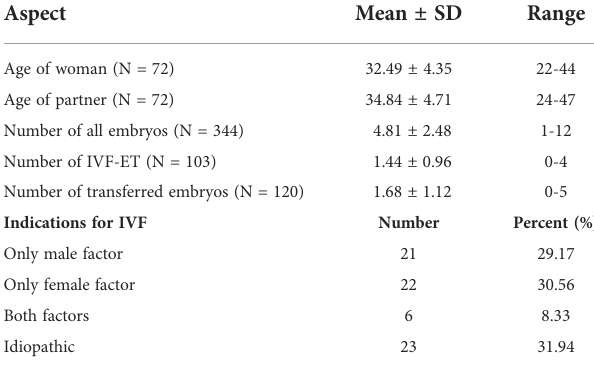
TABLE 1 Clinical characteristics of couples participating in